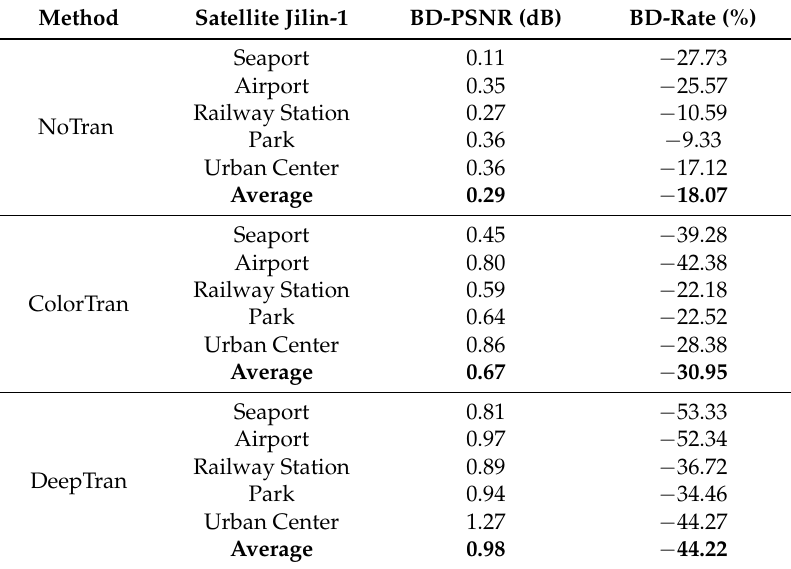
Table 2. Ablation study of the proposed method vs. HEVC with satellite